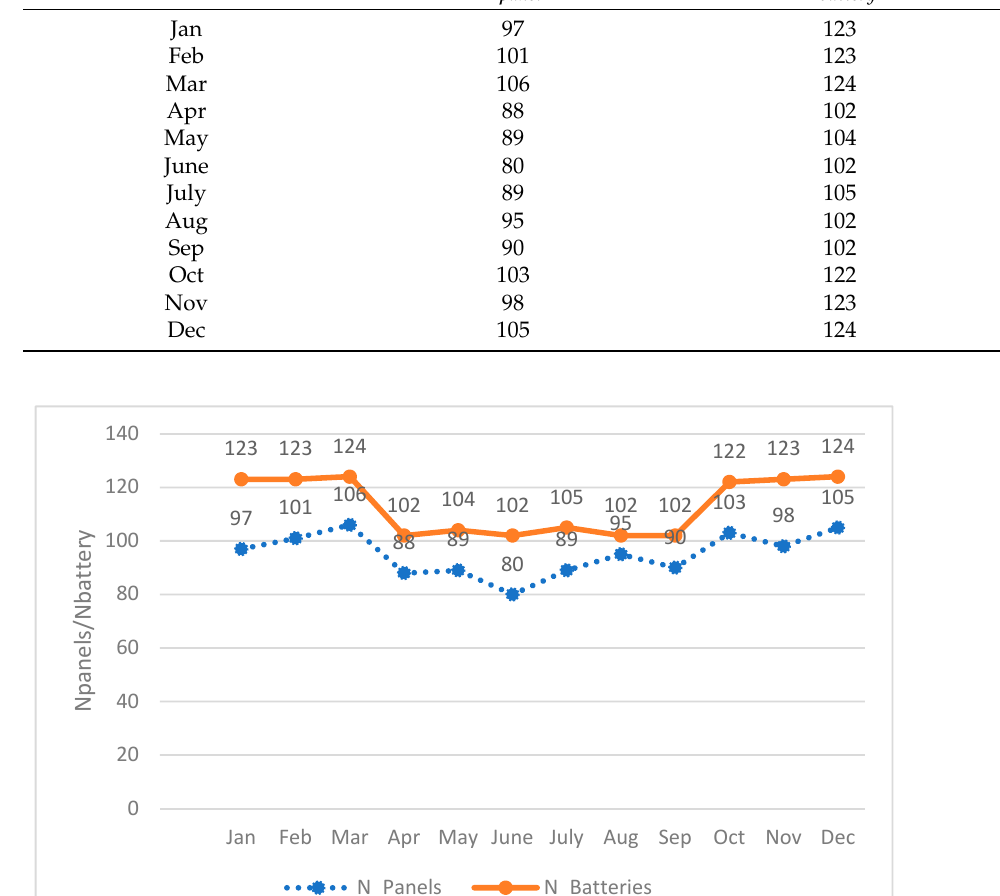
Figure 5. Optimized values for number of panels and batteries.